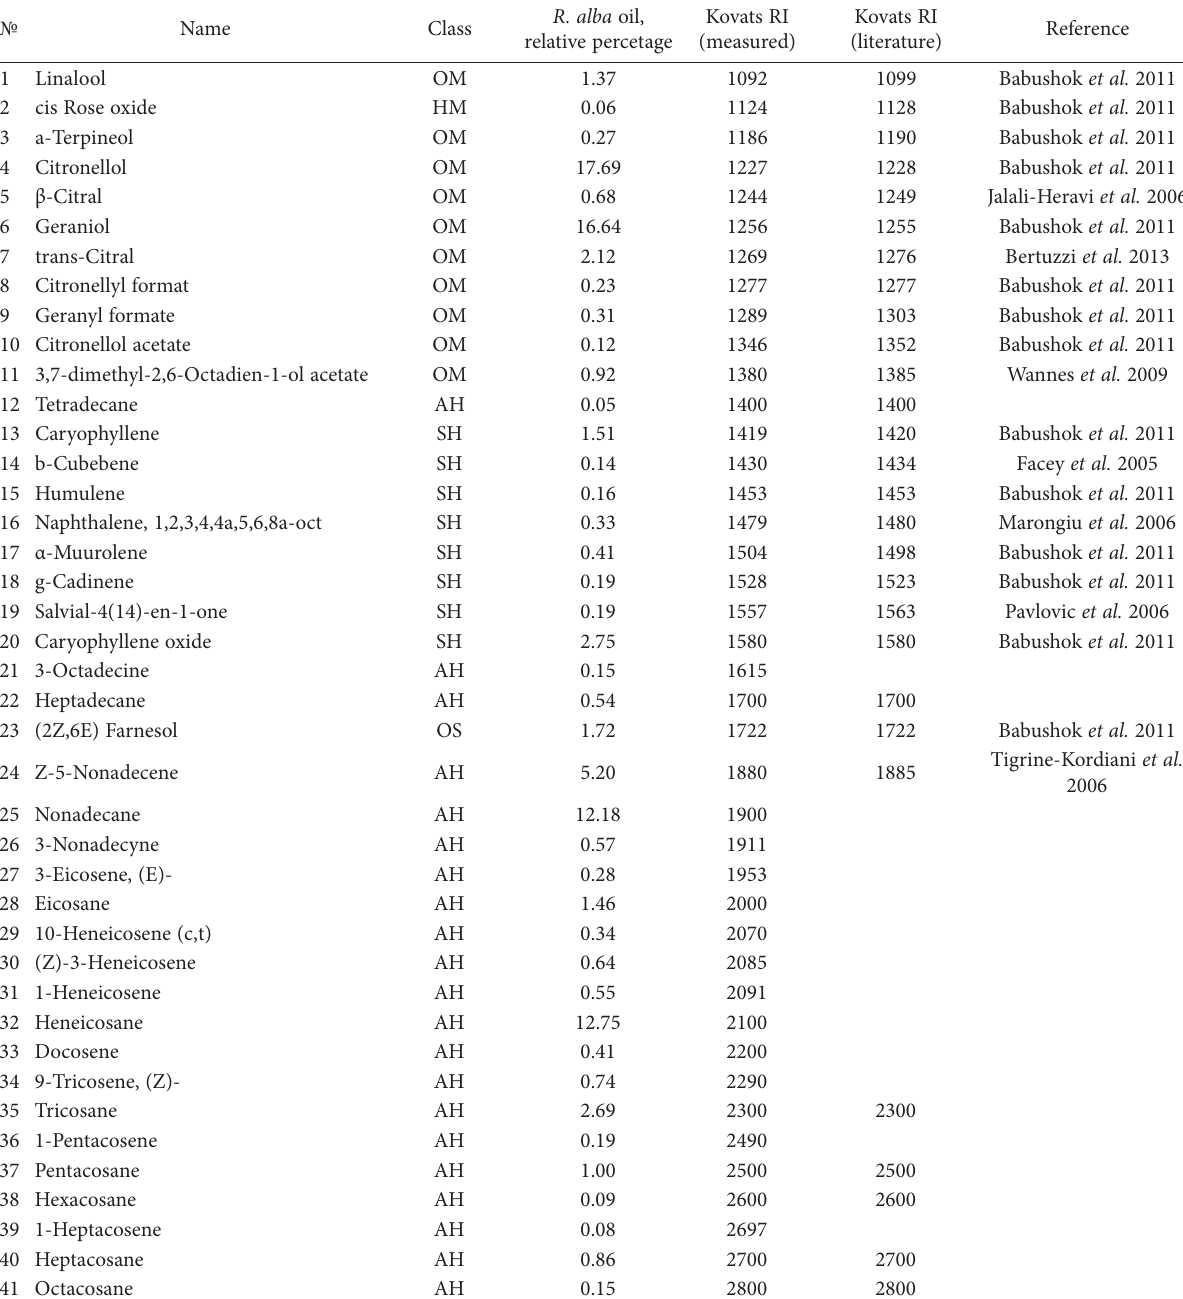
Table 1. Volatile oil constituents of Bulgarian Rosa alba L. essential